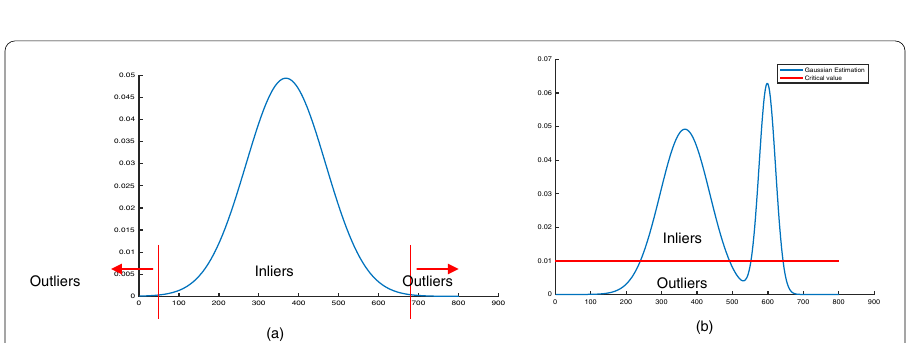
Fig. 2 An Example of Gaussian estimation and marking of critical value for outlier detection. a Points those lie outside the red boundaries are considered outliers. b The points below the critical value are identified as